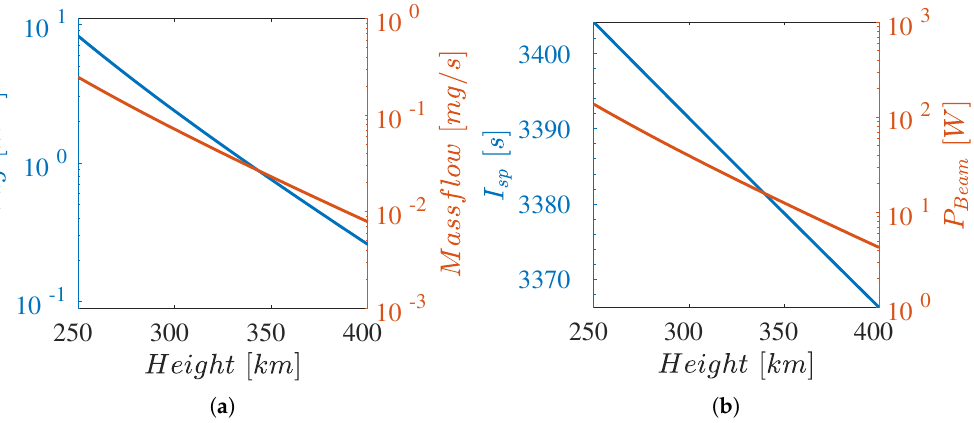
Figure 4. Mission requirements assuming C D = 3.7 and intake efficiency η c = 0.43. ( a ) Drag in function of the orbital altitude and available mass flow; ( b ) Isp in function of the orbital altitude and DI sp g e required thruster’s beam power ( P Beam = 1 2